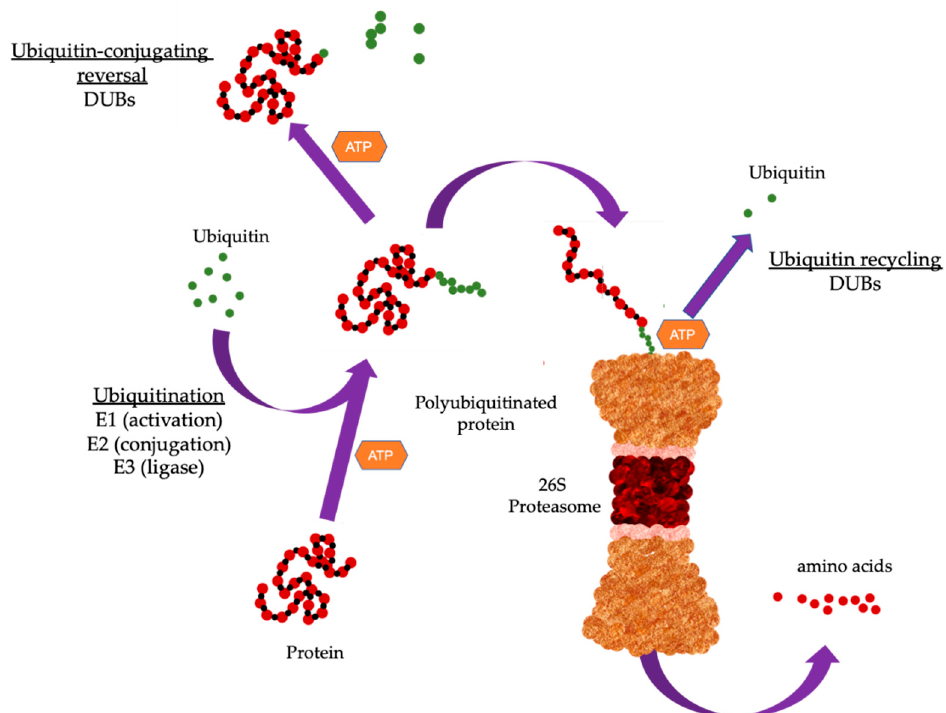
Figure 1. Overview of the ubiquitin proteasome system (UPS). The UPS cascade. Substrate protein is ubiquitinated through the sequential action of three enzymes. E1 binds to activated ubiquitin and is transferred to the ubiquitin-conjugating enzyme (E2). The E2 carries the activated ubiquitin to ubiquitin ligase (E3), which then facilitates the transfer of ubiquitin from E2 to a lysine residue in the target protein. Proteins can be modified with a single mono-ubiquitin molecule, or with ubiquitin chains of different lengths and linkage types. Substrate proteins modified with specific chains are recognized and subsequently degraded by the 26S proteasome. Deubiquitinating enzymes (DUBs) remove ubiquitin from substrate proteins by removing mono-ubiquitination or by trimming or removing the ubiquitin chain. Typically, poly-ubiquitination has been associated with protein clearance through proteasomal degradation while mono-ubiquitination which involves the addition of a single ubiquitin moiety to the substrate protein affects cellular processes.